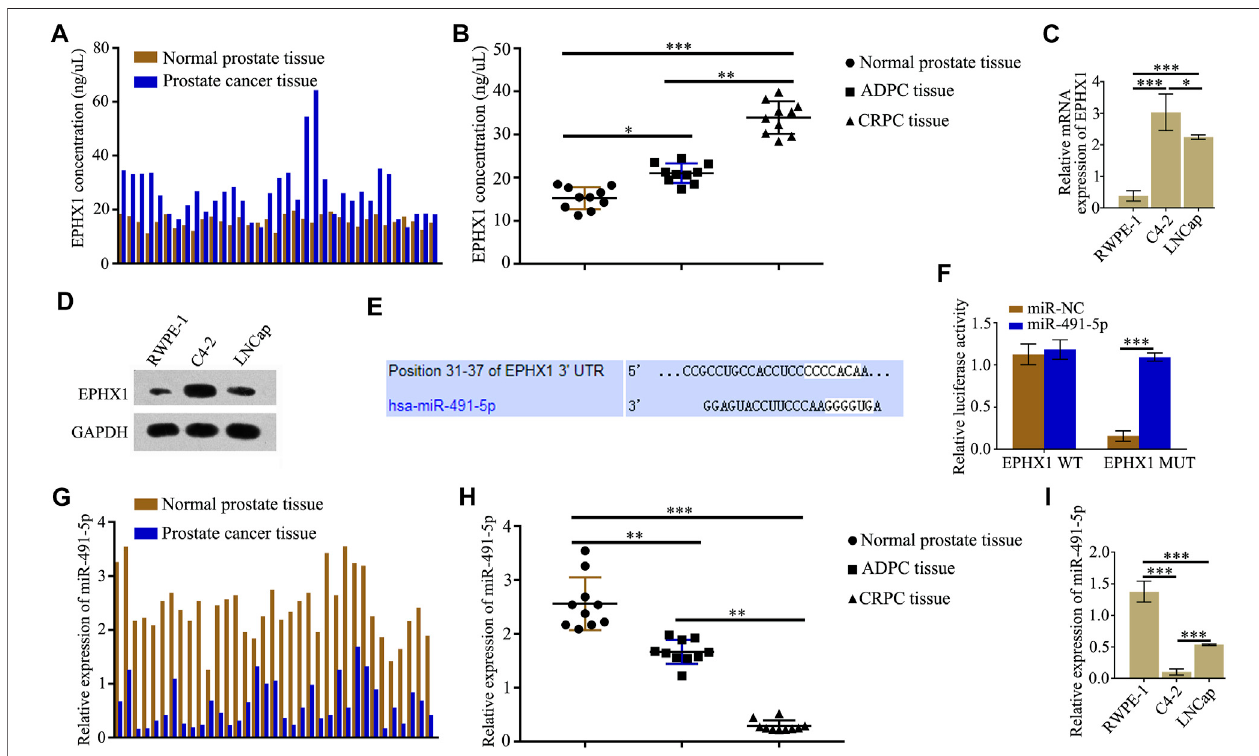
FIGURE1| MiR-491-5pdirectlyregulatedtheexpressionofEPHX1incastration-resistantprostatecancer(CRPC)cells. (A) ELISAwasusedtotesttheexpression of EPHX1 in PCa tissues and cancer-adjacent tissues. (B) Expression of EPHX1 in CRPC tissues was signi fi cantly higher than that in androgen-dependent prostate cancer (ADPC) and normal prostate tissues. (C) QRT-PCR assay was used to detect the mRNA expression of EPHX1 in the CRPC cell line C4-2, the human normal prostate cell line RWPE-1, and the human androgen-dependent prostate cancer cell line LNCap. (D) Western blot assay was used to analyze the protein expression of EPHX1 in C4-2 cells, RWPE-1 and LNCap cells. (E) Online databases TargetScan and starBase were used to predict that miR-491-5p might regulate the expressionofEPHX1. (F) Dual-luciferasereporterexperimentsveri fi edthatmiR-491-5pcoulddirectlybindto3 ′ UTRofEPHX1. (G) QRT-PCRassaywasusedtotestthe expressionofmiR-491-5p inPCatissuesandadjacentnormalprostatetissues. (H) QRT-PCRassaywasusedtodetecttheexpressionofmiR-491-5pinCRPC,ADPC, and normal prostate tissues. (I) QRT-PCR assay was used to detect the expression of miR-491-5p in RWPE-1, C4-2, and LNCaP cells. Data are expressed as the mean ± SD (* p < 0.05, ** p < 0.01, and *** p <